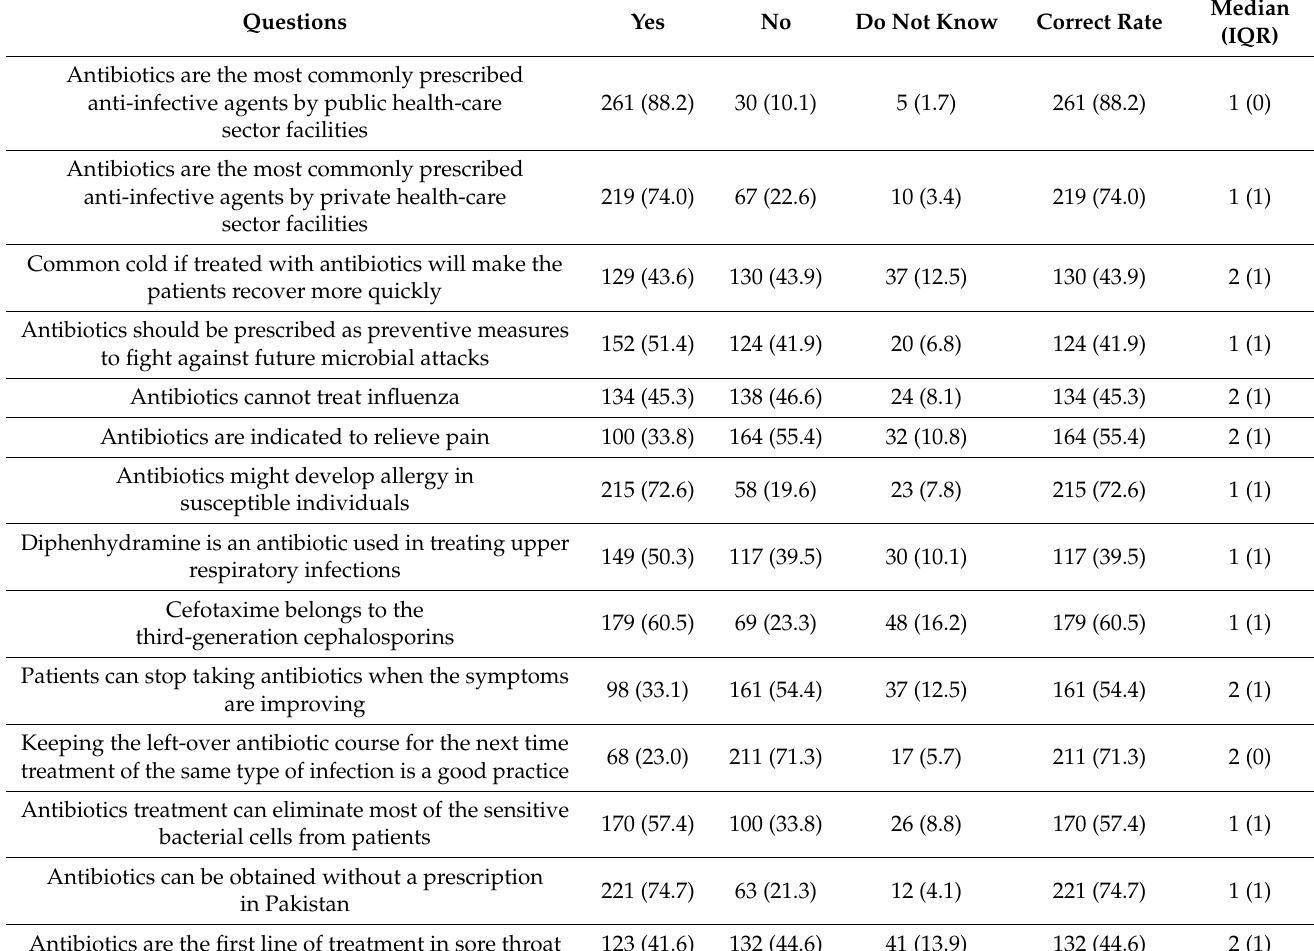
Figure 1. Understanding of respondents towards various aspects of antibiotic use and antibiotic resistance. Table 2. Understanding about antibiotic use n (%).